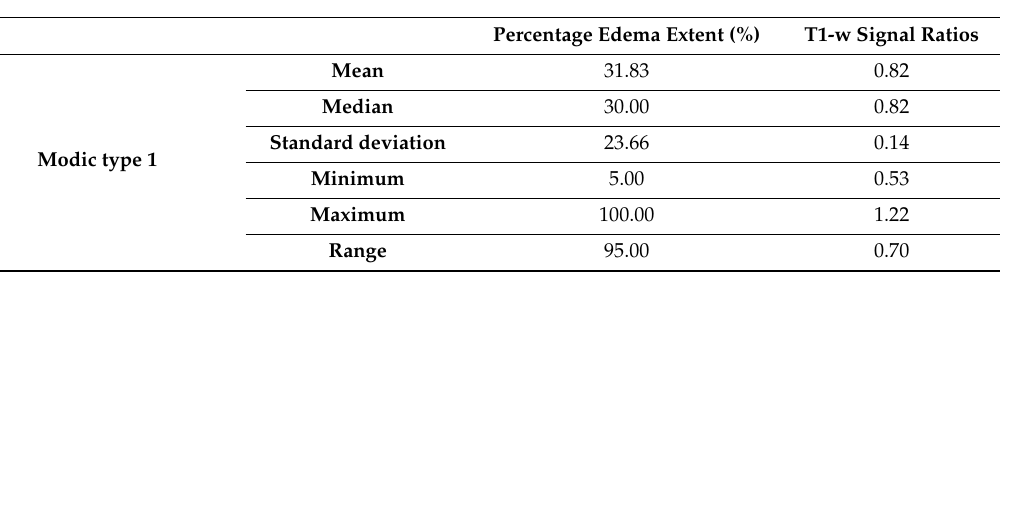
Table 1. Descriptive statistics for the percentage of the extent of vertebral body bone marrow edema and the T1-w signal ratios of edema to una ff ected vertebral